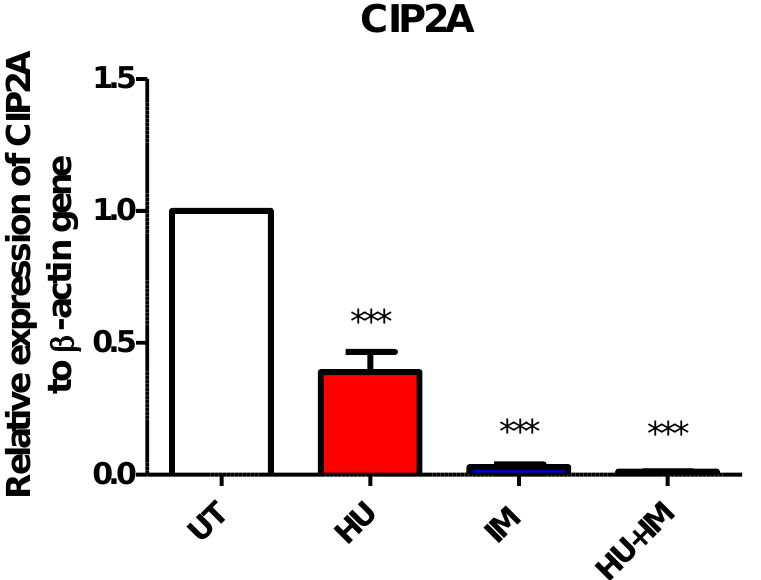
Figure 4. Relative expression of CIP2A to β -actin gene. Two-tailed paired t -test showed a significant statistical difference between UT vs. HU, UT vs. IM, and UT vs. HU + IM (*** p < 0.005). (mean ± SEM; n = 2).